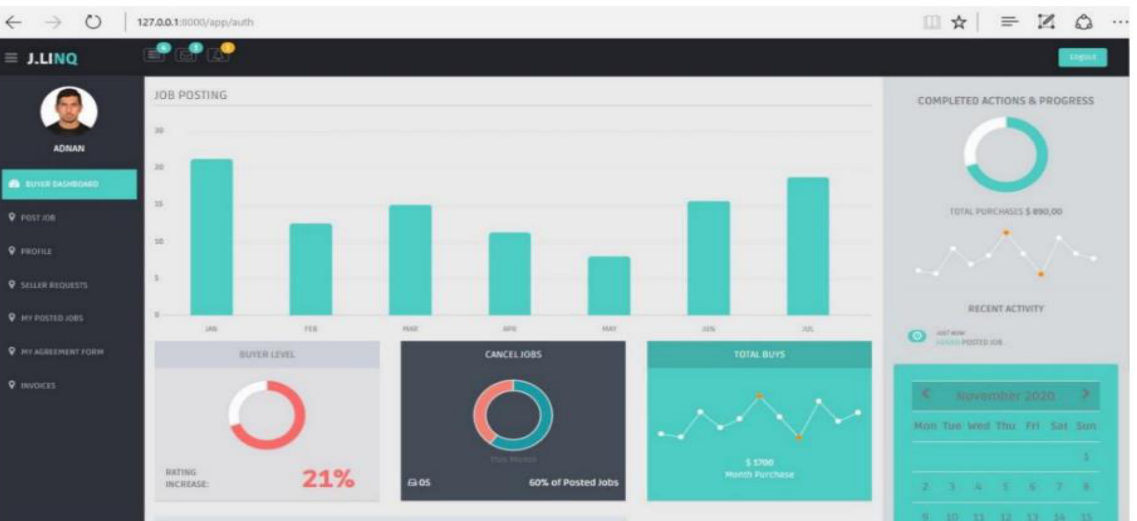
Figure 13. Job posting interface of the system.